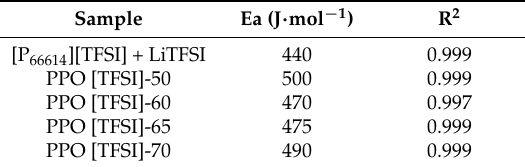
Table 8. Activation energy and correlation coefficients of gelled electrolyte.